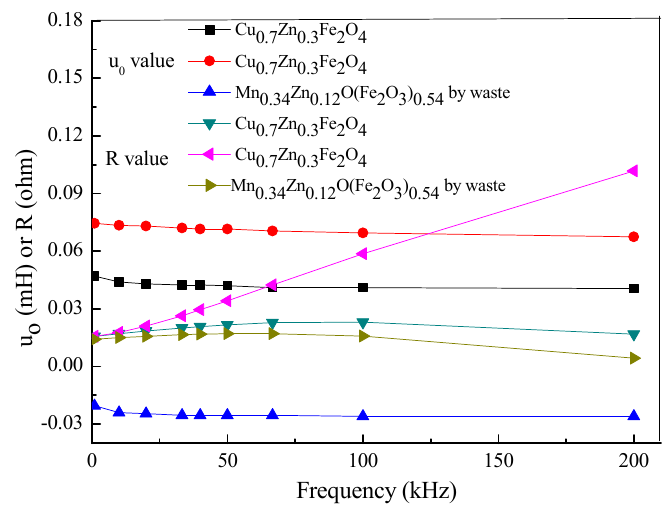
Figure 9. The effect of forming sintering on the µ 0 and R values for different systems.